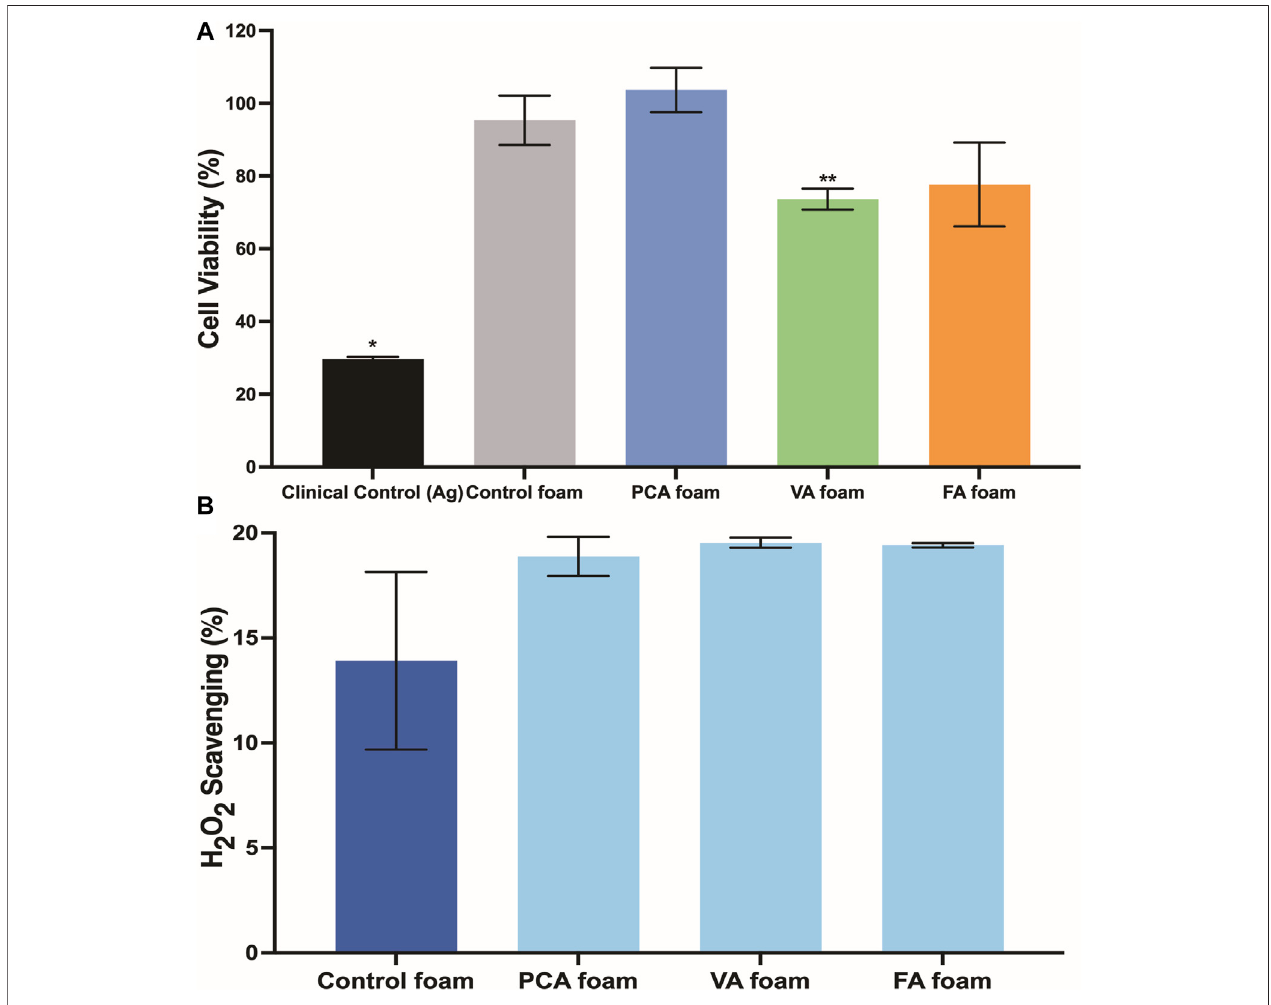
FIGURE 5 | (A) 3T3 fi broblast viability in the presence of PA foams at 24 h n = 3, mean ± standard deviation displayed, * p < 0.05 relative to all other samples; ** p < 0.05 relative to control foam. (B) Antioxidant properties of PA-containing SMP foams as quanti fi ed by hydrogen peroxide scavenging. n = 3, mean ± standard deviation